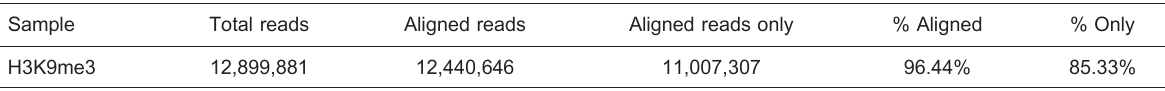
Table 2. ChIP-seq and alignment